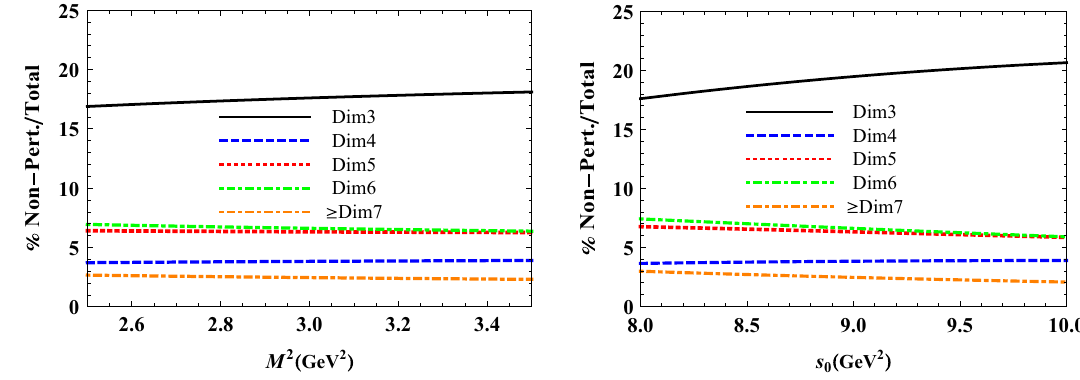
Fig. 2 Contributions due to different nonperturbative terms in the case of Z S as functions of M 2 (left panel), and s 0 (right panel)